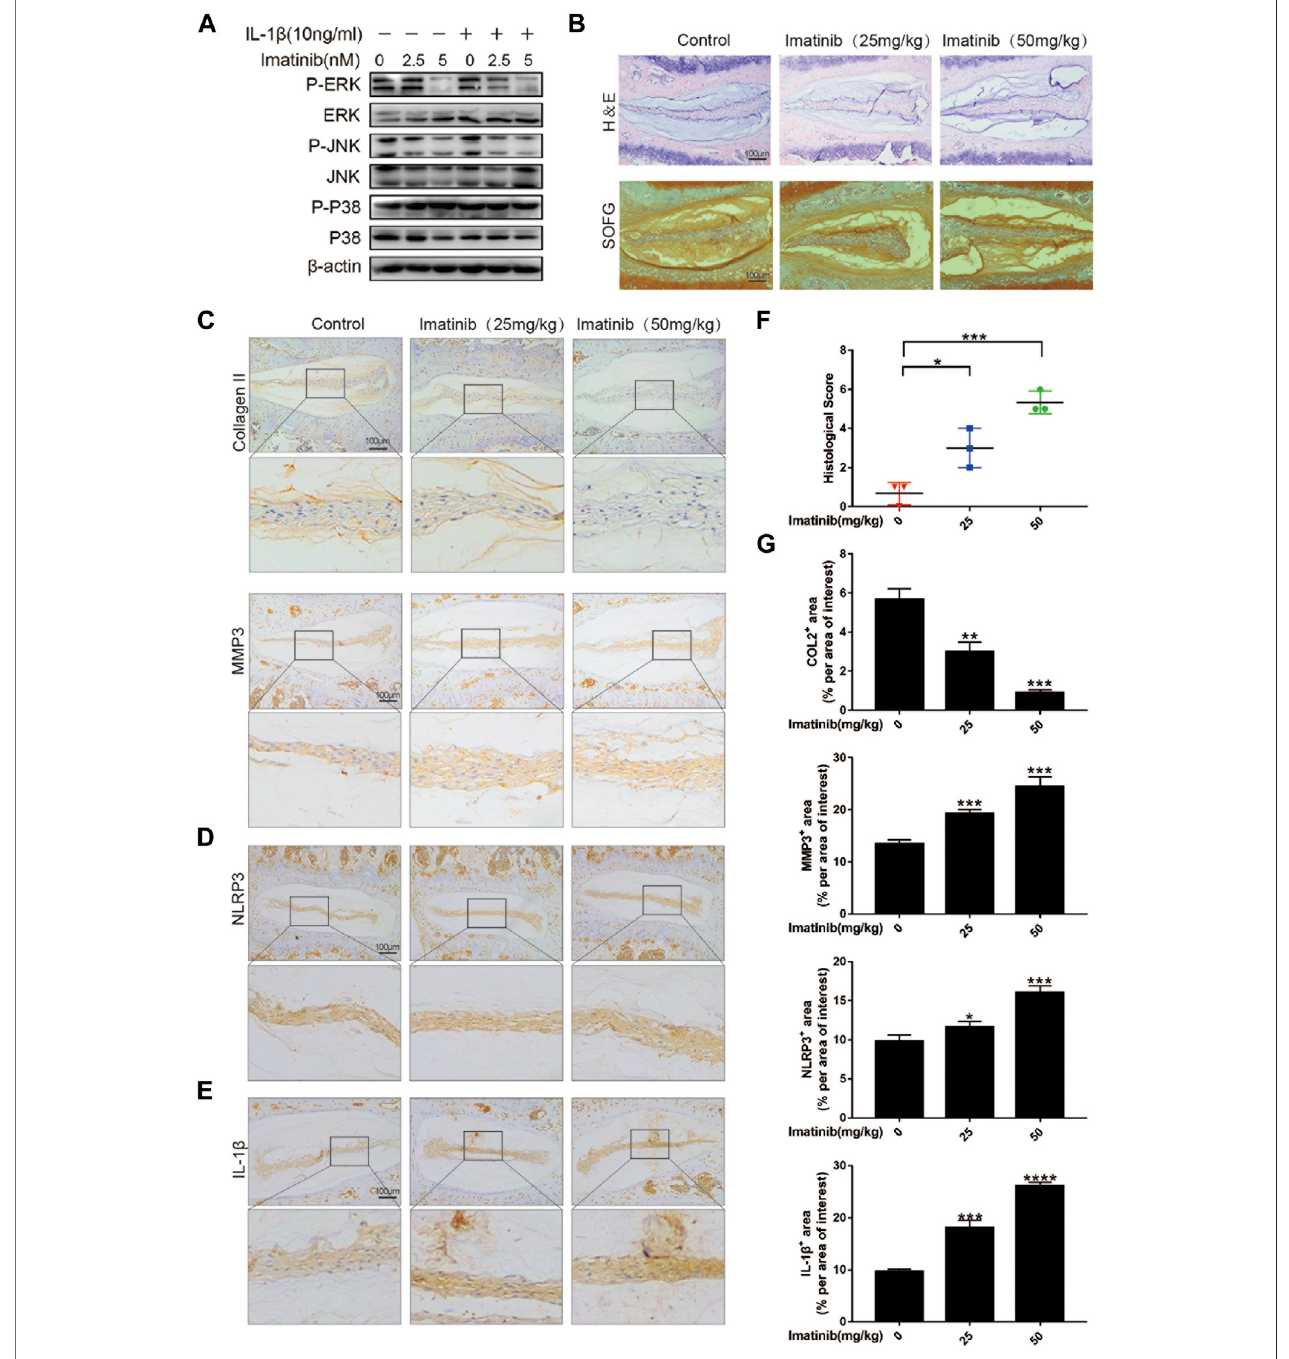
FIGURE 7| Blocking the PDGF-BB receptor accelerates disc degeneration in vivo . (A) Western blot showed the Imatinib alleviation effects on the phosphorylation ofERKandJNK,butnotP38. (B) HematoxylinandeosinstainingandSafraninO-Fastgreenstainingwereperformedafter8 weeksofintraperitonealinjection.Scalebar, 100 μ m. (C – E) Immunohistochemical images of COL2, MMP3, NLRP3 and IL-1 β of intervertebral disc. n (cid:1) 3. Scale bar, 100 μ m. (F) Histologic score of intervertebral discs in each group. (G) Average percentage of positive staining area of intervertebral disc in each group. Data are presented as the mean ± SD. Signi fi cant differences between groups are indicated as **** p < 0.0001, *** p < 0.001, ** p < 0.01, * p < 0.05.